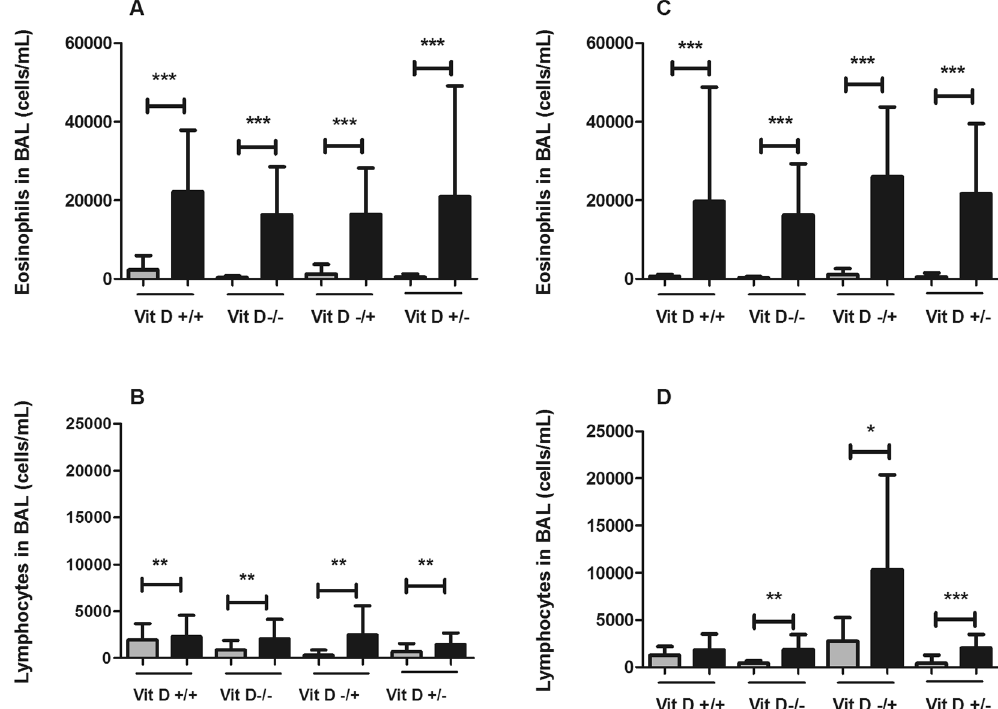
Figure 6. Eosinophil ( A , C ) and lymphocyte ( B , D ) cell counts in the BAL of female ( A , B ) and male ( C , D ) mice that were whole-life replete (Vit D + / + ), whole-life deficient (Vit D − / − ), in utero deficient (Vit D − / + ) or postnatally deficient (Vit D + / − ) in vitamin D and exposed to 25 µ g of house dust mite (HDM; black bars) intranasally in 50 µ L of saline or saline alone (grey bars) for 10 consecutive days. Data are presented as mean (SD), n = 8–11 for each group in females and 7–11 in males. * p < 0.05; ** p < 0.01; *** p <